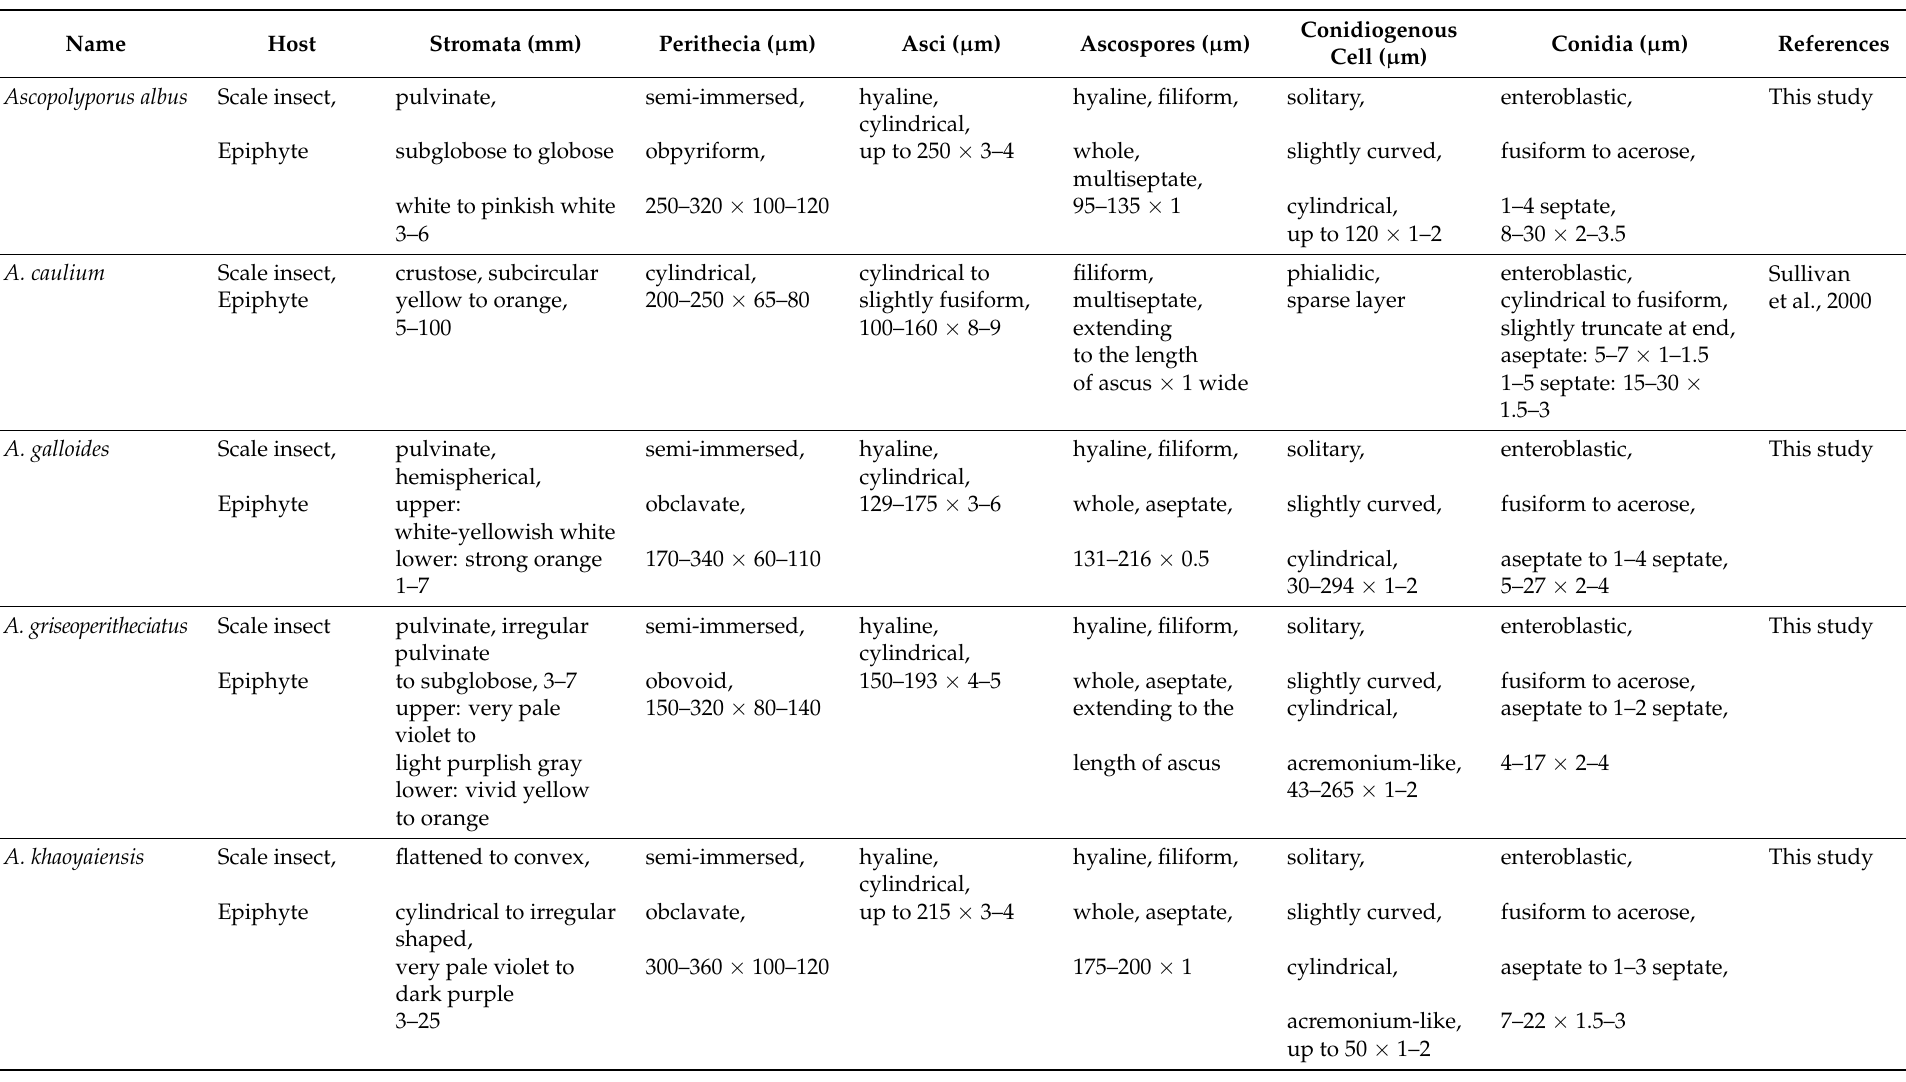
Table 2. Morphological comparisons of Ascopolyporus and related species. NA, not